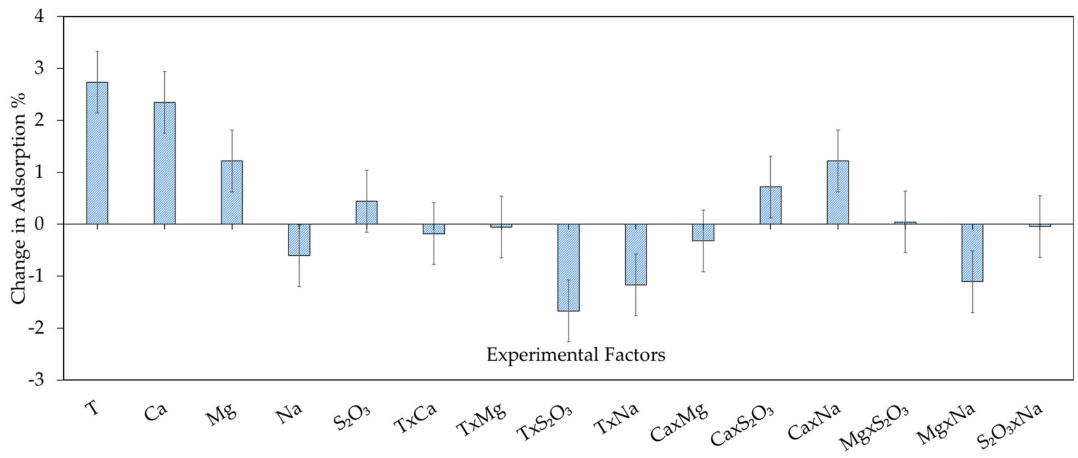
Figure 2. E ff ect of water constituents and the interaction on xanthate adsorption on a chalcopyrite surface. Error bars a calculated based on 95% confidence intervals. Insignificant terms with error bars spanning the positive and negative y axis are removed from the final regression model.